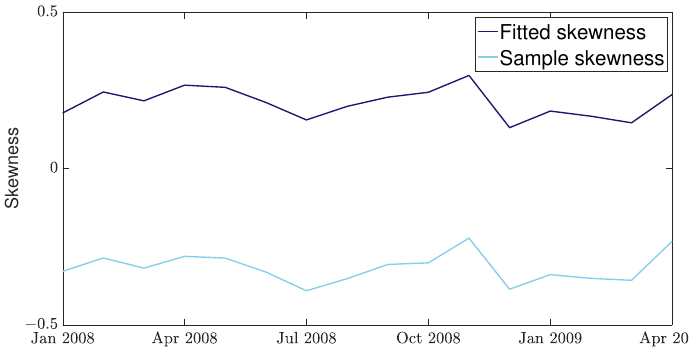
Figure 4. Comparison of sample skewness for each month with that of the fitted beta distribution in the interval ( 0,1 )